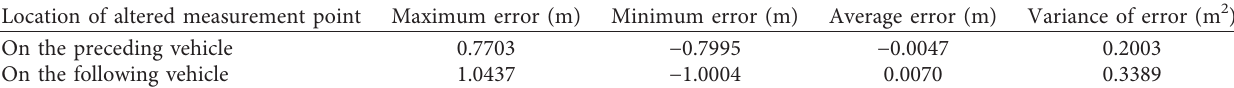
Figure 7: Distribution of errors in space headway estimation when the locating offset of a measurement point on a different vehicle is altered: (a) altering a measurement point on the preceding vehicle; (b) altering a measurement point on the following vehicle. Table 2: Characteristics of space headway estimation errors when the locating offset of the measurement point on a different vehicle is